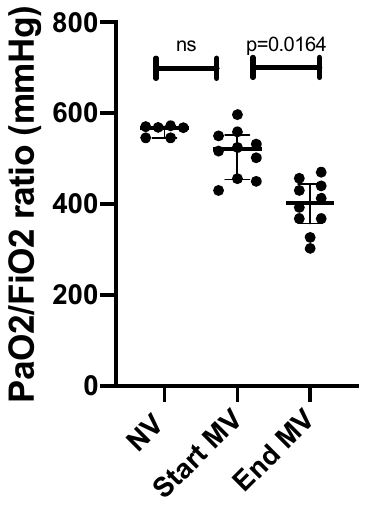
Figure 7. Dot plot showing the PaO 2 /FiO 2 ratio of the NV group (568 mmHg; 546–571), the PaO 2 /FiO 2 ratio of the MV group at the start of the experiment (521 mmHg; 454–552) and the PaO 2 /FiO 2 ratio of MV group at the end of the experiment (403 mmHg; 357–444). No statistically significant difference was found when comparing the PaO 2 /FiO 2 ratio of the NV group (568 mmHg; 546–571) to the PaO 2 /FiO 2 ratio of the MV group at the start of the experiment (521 mmHg; 454–552, p = 0.3700). The PaO 2 /FiO 2 ratio of MV group at the end of the experiment (403 mmHg; 357–444) when compared to the PaO 2 /FiO 2 ratio of the MV group at the start of the experiment (521 mmHg; 454–552, p = 0.0164) was statistically